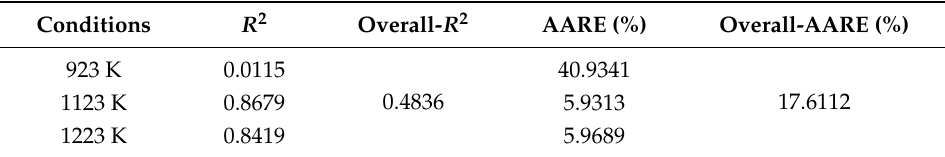
Table 5. Statistical measurements of the optimized JC